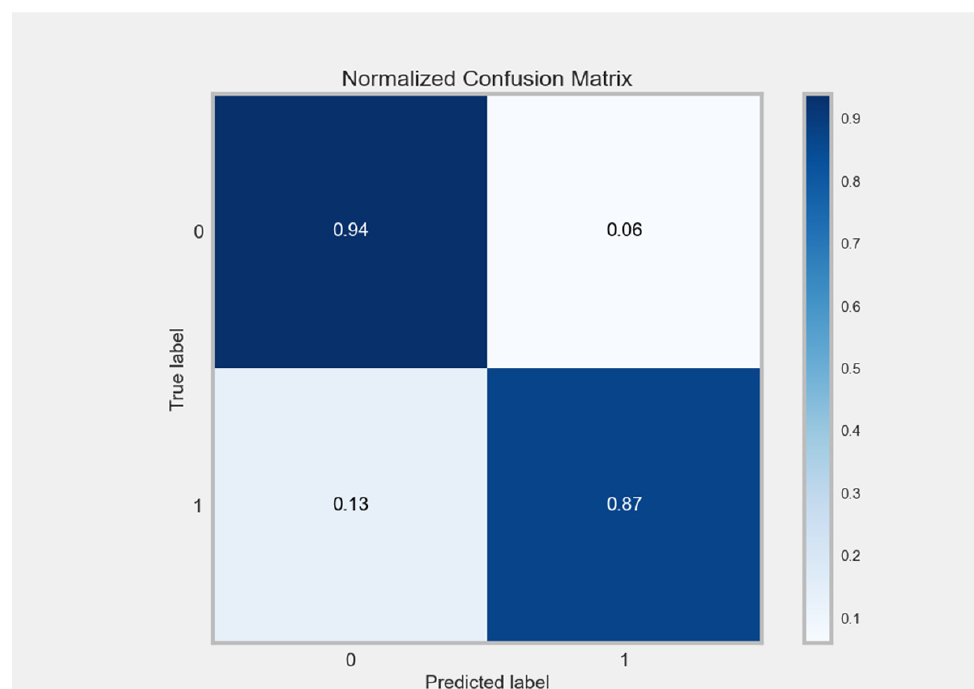
Figure 12. Normalized Confusion matrix for LightGBM model.